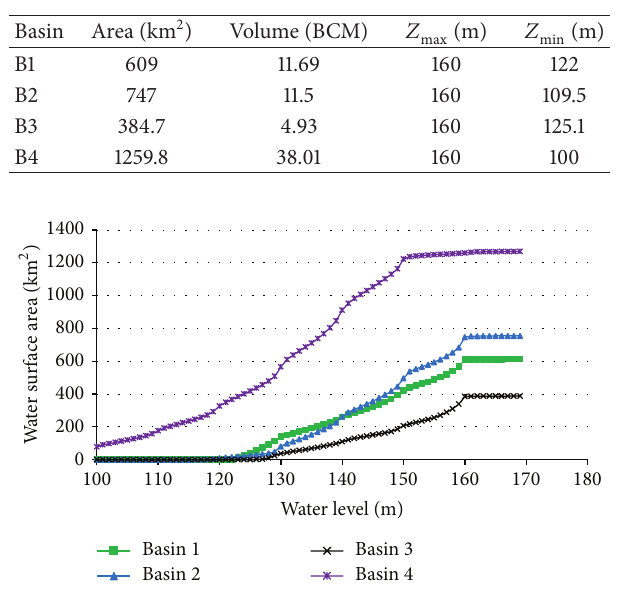
Table 2: LAV output of basin capacities.